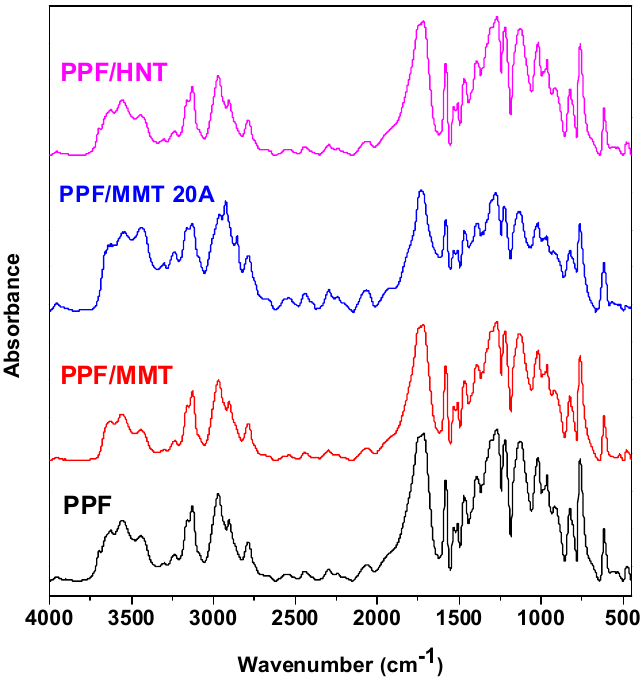
Figure 4. FTIR spectra of PPF and its nanocomposites.